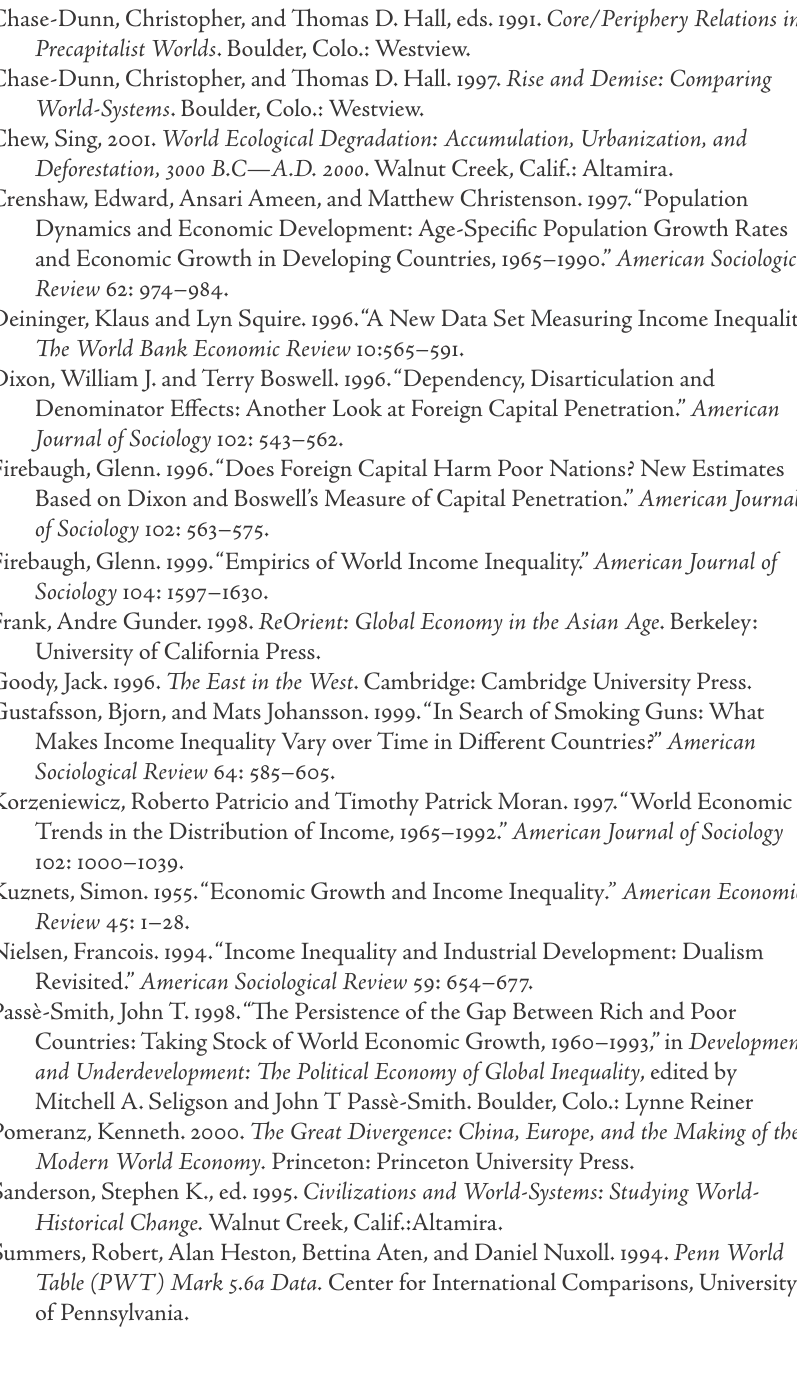
Table (PWT) Mark 5.6a Data. Center for International Comparisons, University of